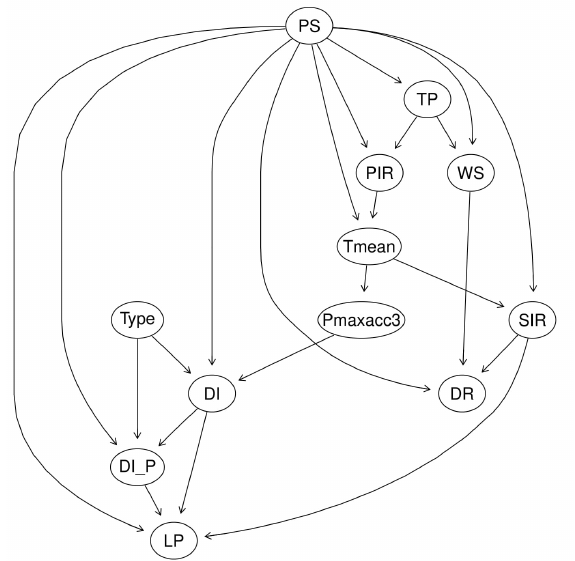
Figure 7. DAG representation of Bayesian network model structure learned by algorithmic learning. The structure was learned from bootstrap sampling technique under 5000 iterations with arc strength above 0.8 and arc direction above 0.5. Variables learned in this Bayesian network are a combination of observed climate variables and the estimated development factors of grapevine and the pathogen of grape PM. Variables in the DAG representation include: plant stage (PS), total precipitation (TP), daily mean temperature (Tmean), wind speed (WS), degree-days based risk assessment model P maxacc3 (3 ◦ C), latent period (LP), primary infection rate (PIR), secondary infection rate (SIR), dispersal rate (DR), recent disease incidence ( DI P ), cultivar (Type), and disease incidence